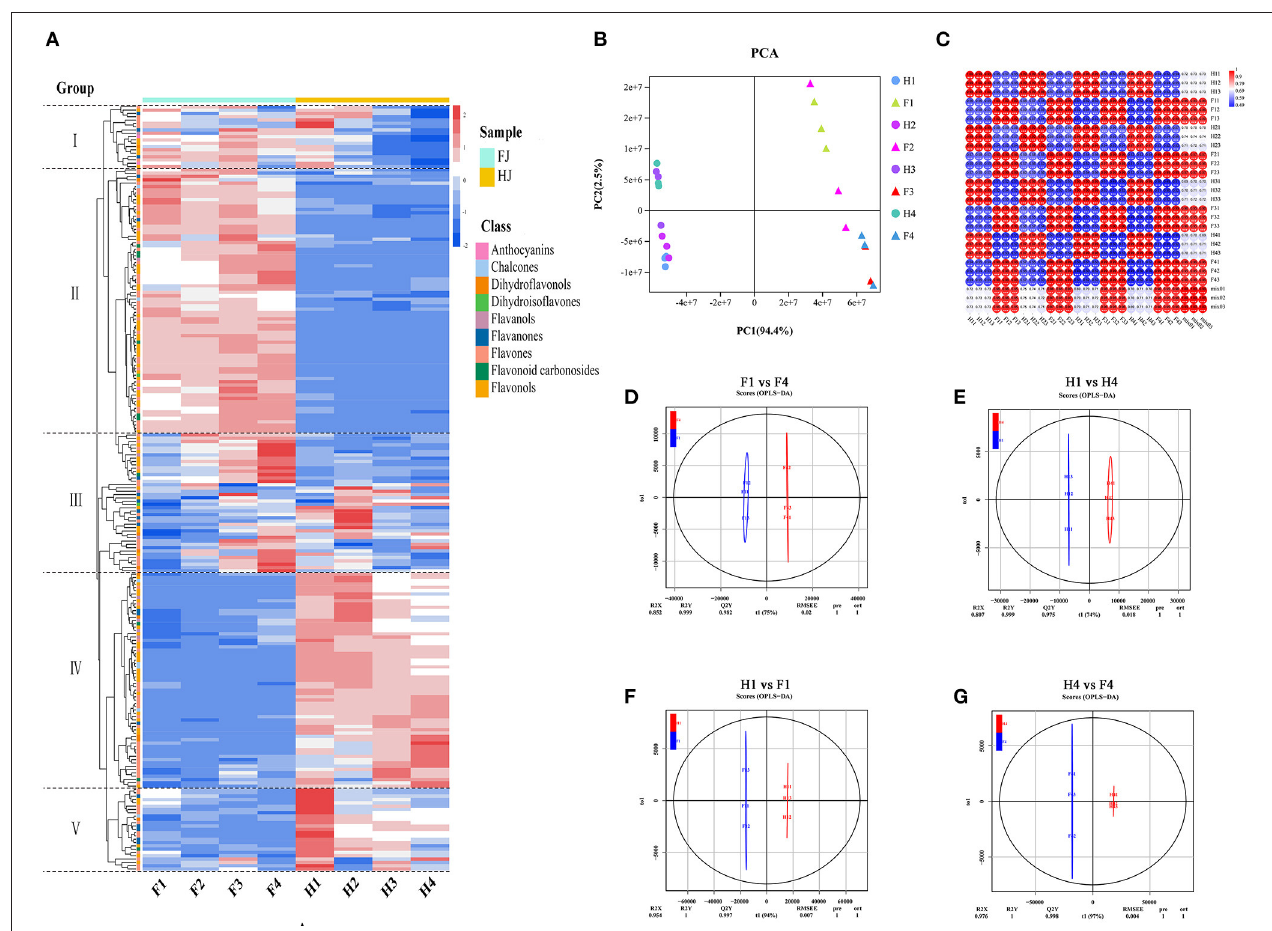
FIGURE 2 | Analysis of flavonoid metabolites in FJ and HJ leaves under drought stress. (A) : Heat map cluster analysis of 231 flavonoids. High and low abundance are indicated by red and blue colors, respectively. (B) : PCA score plot of 24 samples based on flavonoid abundances. (C) : Correlation coefficient graph of 24 samples. (D–G) : OPLS-DA plots for F1 vs. F4, H1 vs. H4, H1 vs. F1, and H4 vs. F4, respectively.